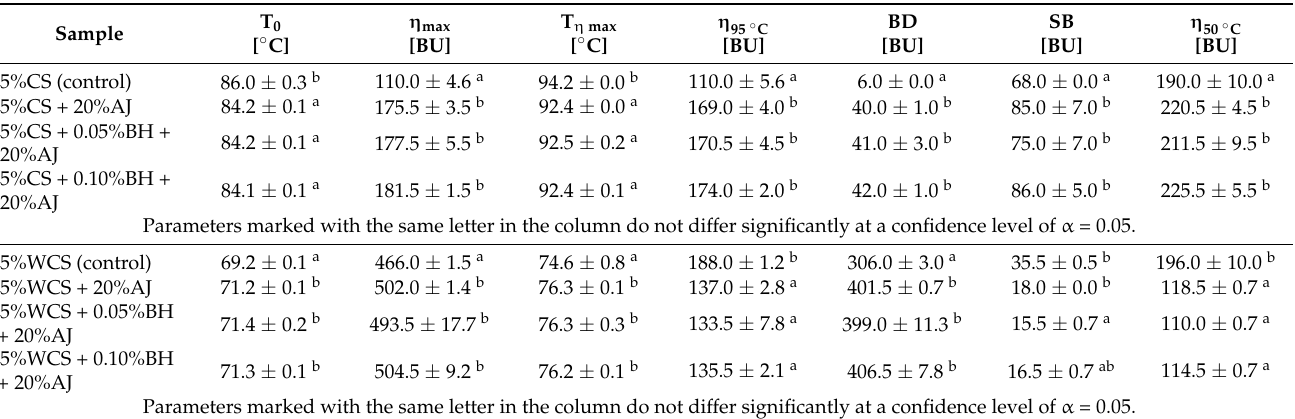
Table 3. Parameters of the pasting characteristics of corn starch gels and starch gels with buckwheat